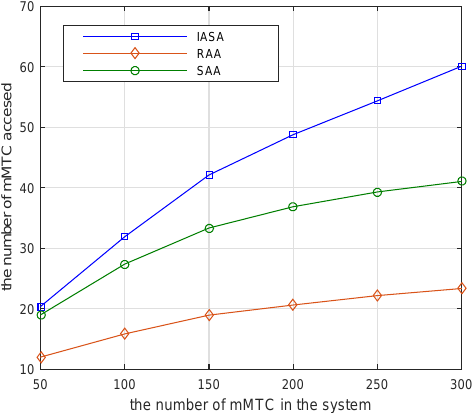
Figure 6. Number of mMTC pairs accessed versus different number of mMTC